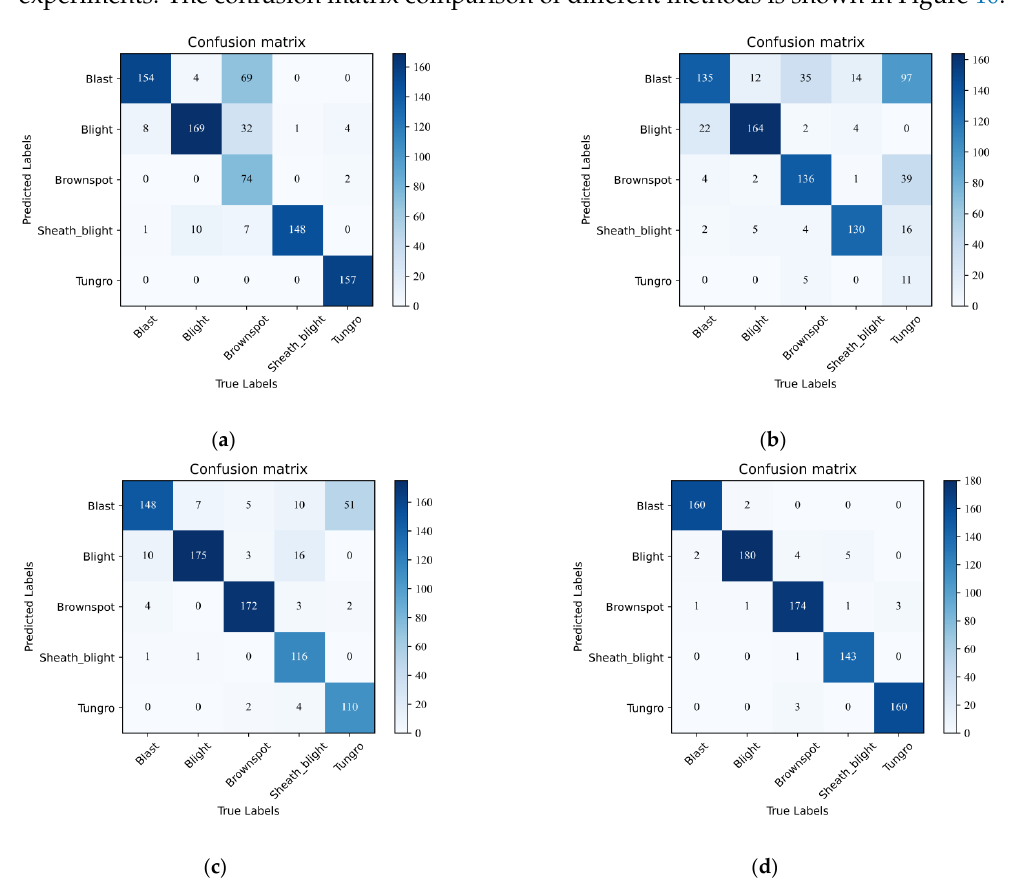
Figure 10. Confusion matrix comparison of different methods: ( a ) DenseNet; ( b ) VGG; ( c ) ResNet; and ( d ) Vision Transformer.